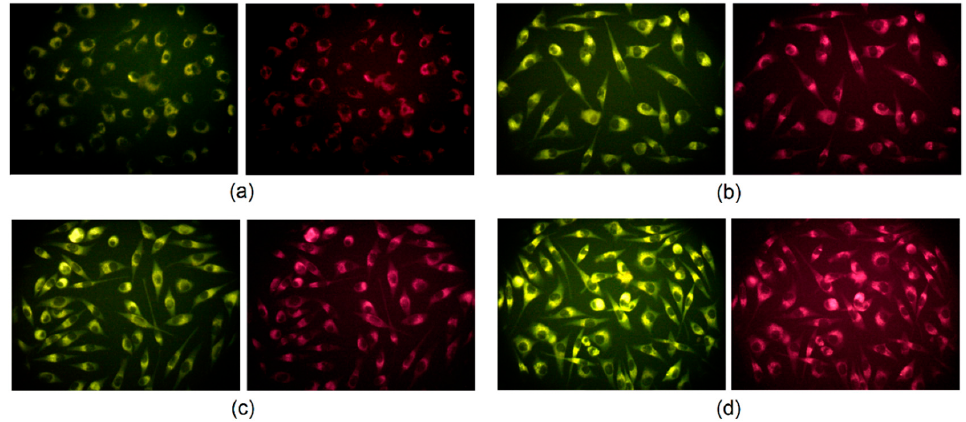
Figure 12. L929 mouse fibroblast visualization after 24 h of incubation: ( a ) CQDs-4 (emission at 520 nm); ( b ) CQDs-6 (emission at 590 nm); ( c ) CQDs-7 (emission at 520 nm); ( d ) CQDs-8 (emission at 590 nm) .